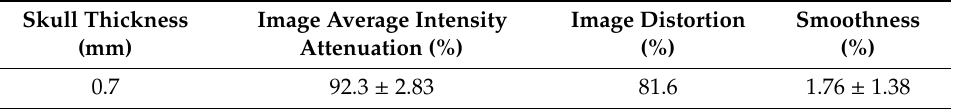
Table 4. Summary of the quantitative evaluation of the PA imaging through the skull in gelatin with the fiber mixture when both the light illumination and acoustic propagation paths are blocked by the skull.